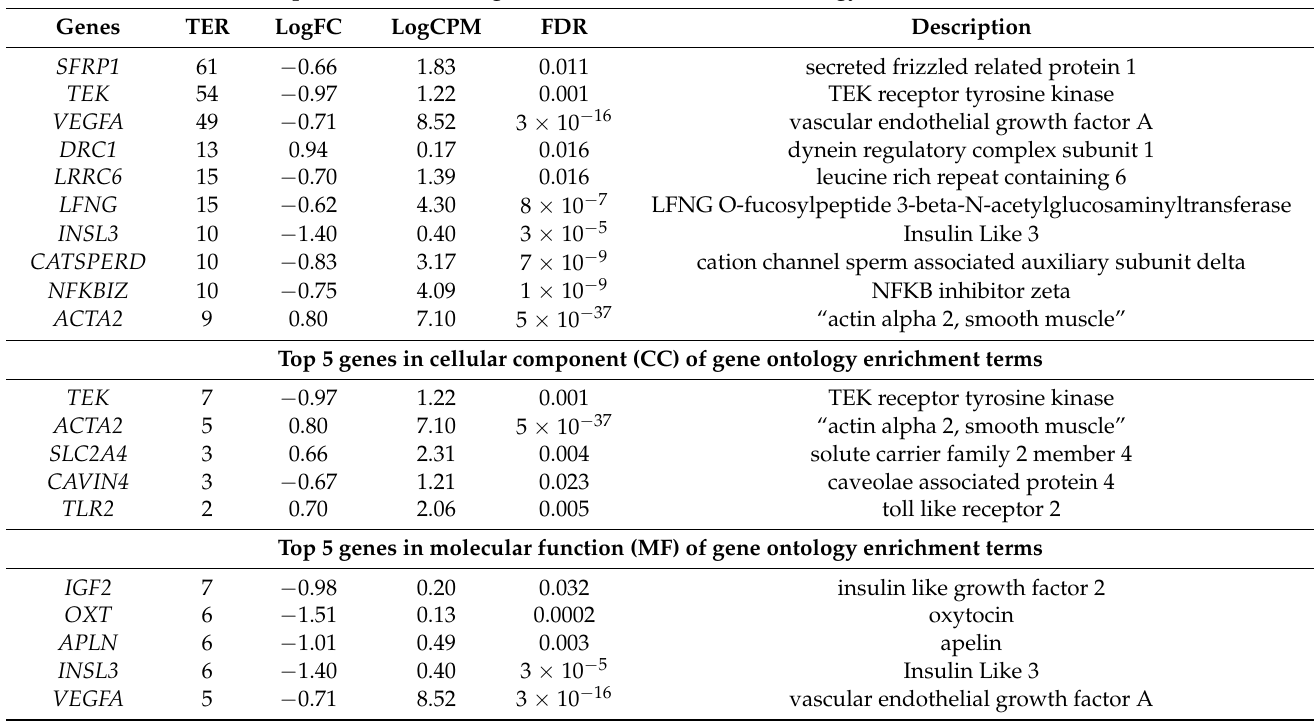
Table 4. Detailed annotation of gene ontology terms (GO) of significant differentially expressed genes (DEGs) in control versus acute heat stress treatment groups was carried out. Top 10 DEGs enriched in various terms of biological process (BP) and top 5 enriched DEGs in cellular component (CC) and molecular function (MF) are detailed along with their term enrichment ratio and statistical detailing.